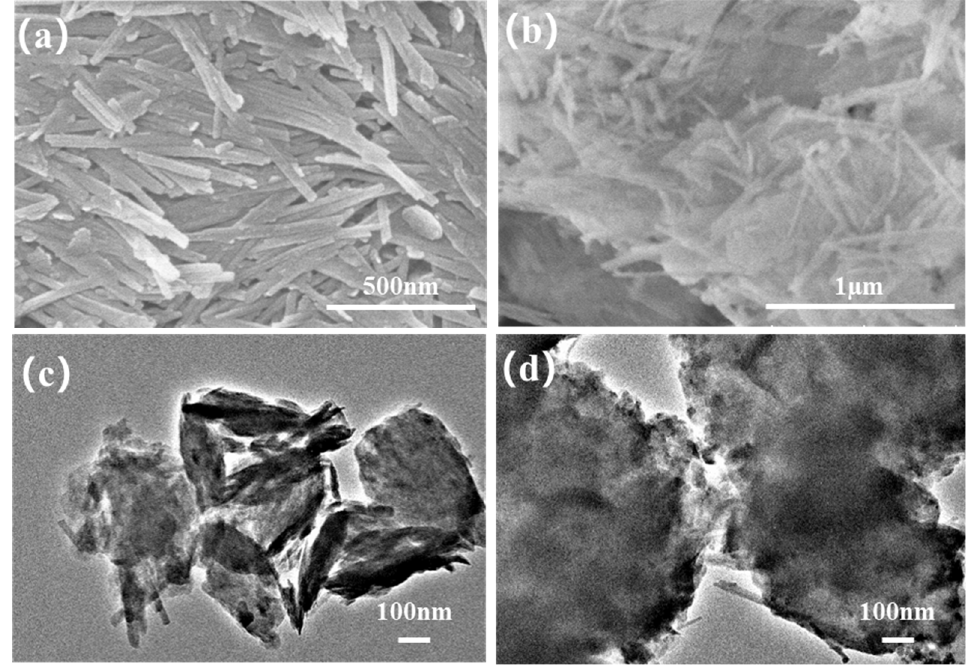
Figure 1. SEM images of ( a ) attapulgite and ( b ) MXene/attapulgite composite (1:2); TEM images of ( c ) attapulgite and ( d ) MXene/attapulgite composite (1:2).